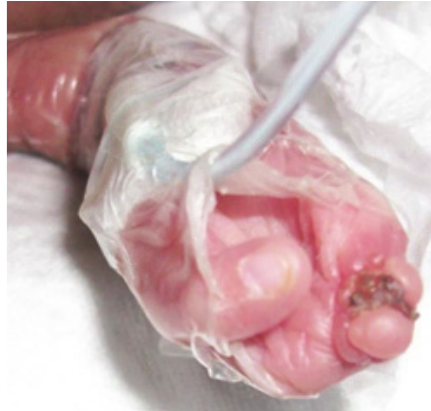
Figure 3: Right hand, only thumb present.